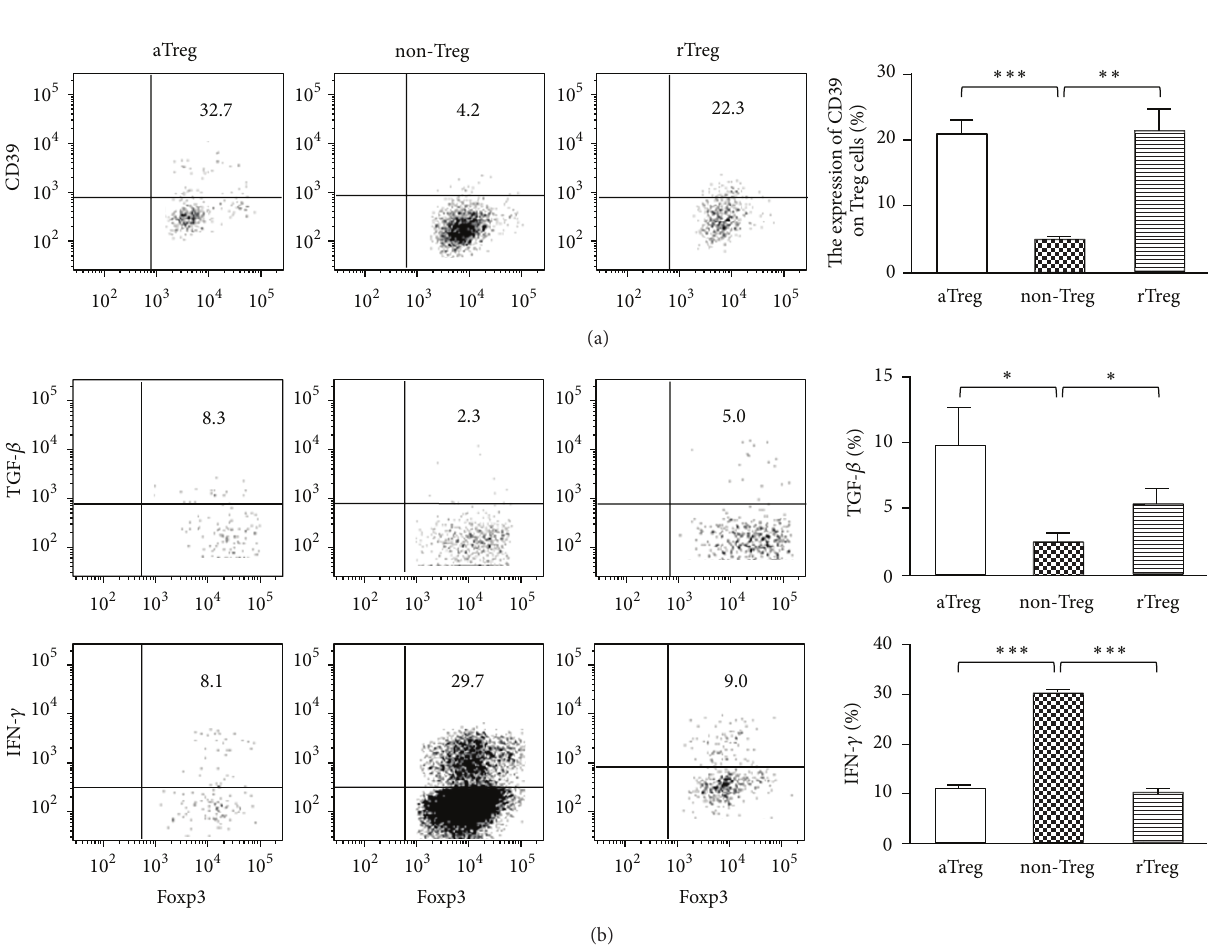
Figure 2: aTreg cells expressed higher immunosuppressive marker CD39 in NSCLC patients and secreted suppressive cytokines. (a) PBMCs were collected from NSCLC patients. The phenotype marker of CD39 was evaluated in the three subsets of CD4 + Foxp3 + Treg cells, including aTreg, non-Treg, and rTreg cells. The dot plots (left) represent the expression of CD39 in each group. The bar figures (right) represent the mean percentage of each population ± standard error of mean. (b) These cells were also stimulated in vitro and the cytokine profiles including TGF- 𝛽 and IFN- 𝛾 were analyzed. ∗ 𝑃 < 0.05 ; ∗∗ 𝑃 < 0.01 ; ∗∗∗ 𝑃 < 0.001 by paired 𝑡